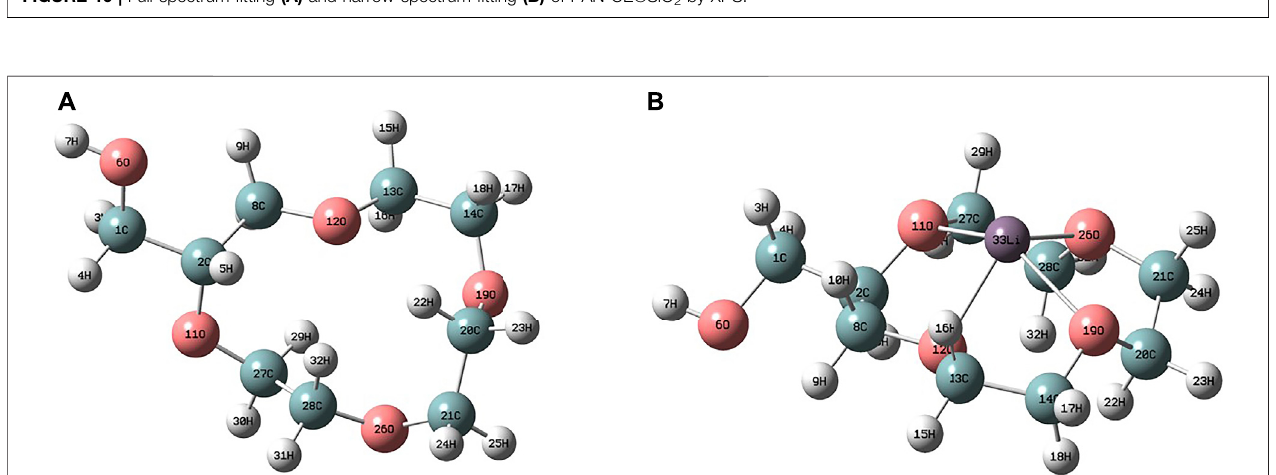
FIGURE 11 | Structural optimisation before (A) and after (B) the adsorption of PAN-CE@SiO 2 for Li(I).